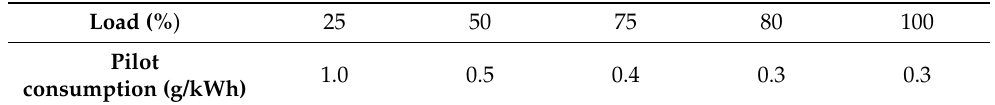
Table 2. Pilot consumption in diesel mode.